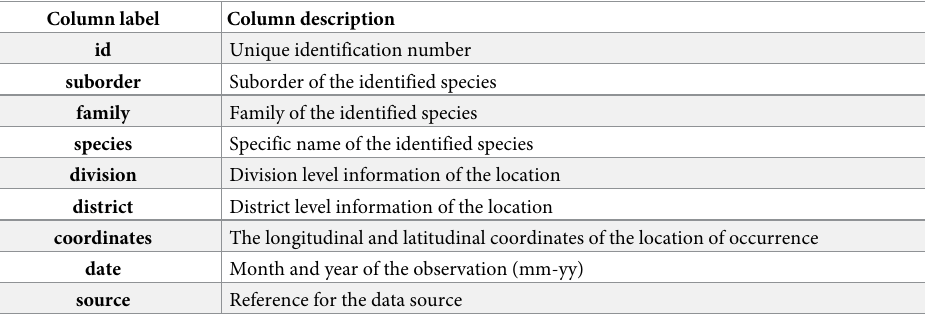
Table 2. Data structure and variable definition of OdoBD_occurrence